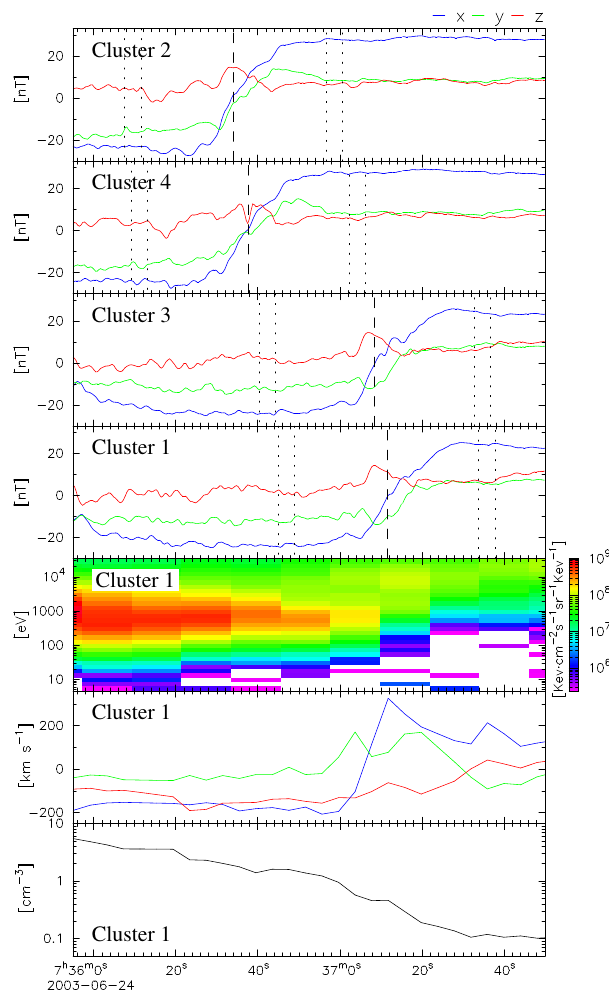
Fig. 2. First four panels: Magnetic field in GSE reference frame measured by Cluster during the MP crossing on 24 June 2003. The panel order, i.e. C2, C4, C3, and C1, corresponds to the sequence of MP encounter. The x, y, and z components are indicated by the blue, green and red lines, respectively. The minimum and maximum length intervals entering the MVAB nested analysis (vertical dot- ted lines) together with their common central time (vertical dashed lines) are shown for each satellite. Last three panels: Ions differ- ential energy spectrogram, bulk velocity components in GSE, and density, as measured by the CIS/Hot Ion Analyser on-board C1.